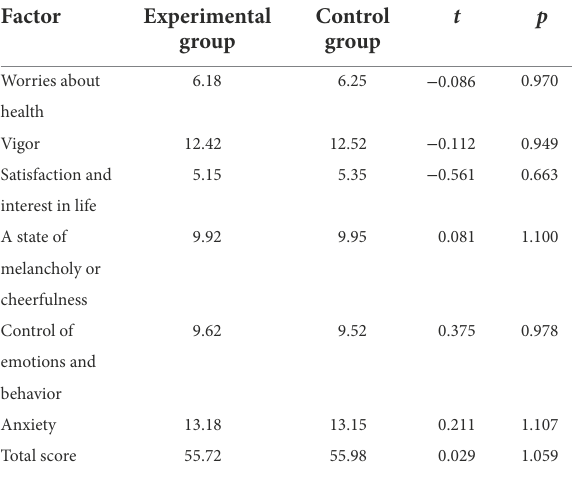
TABLE 9 The well-being scale of the experimental group and the control group before the experiment. Factor Experimental